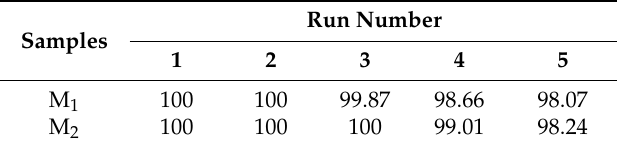
Table 4. Degradation efficiency through five consecutive catalysts reuse cycles.